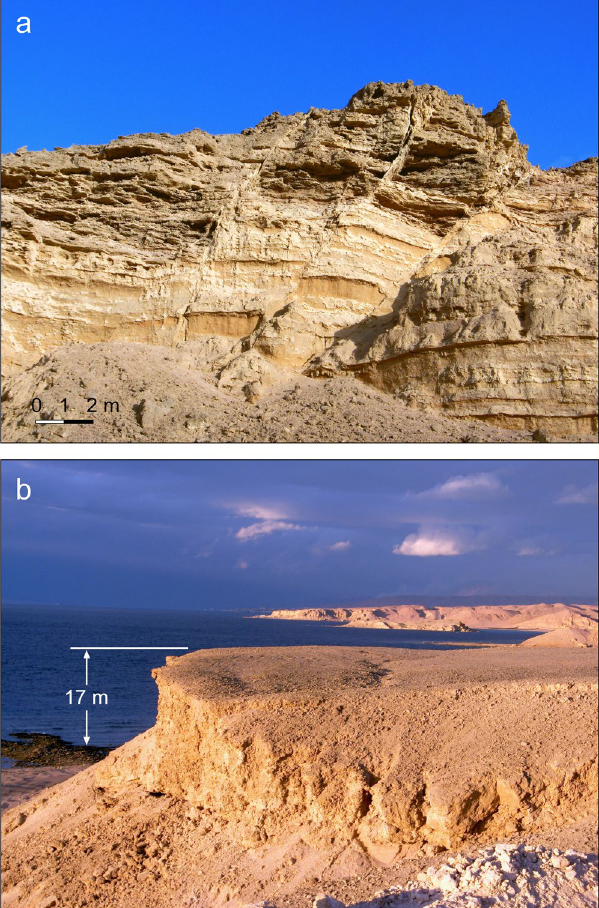
Figure 5. Examples of the Plio-Pleistocene exposures described in this study near Haql, Saudi Arabia (station 6 in Figs 3 and 4). ( a ) Extensional faults cutting partially lithified sandstone and conglomerate stratigraphically beneath the Pleistocene terraces of the coastal region. ( b ) Last interglacial (Marine Isotope Substage 5e) coral terrace. Terrace is approximately 17 m above sea level at this